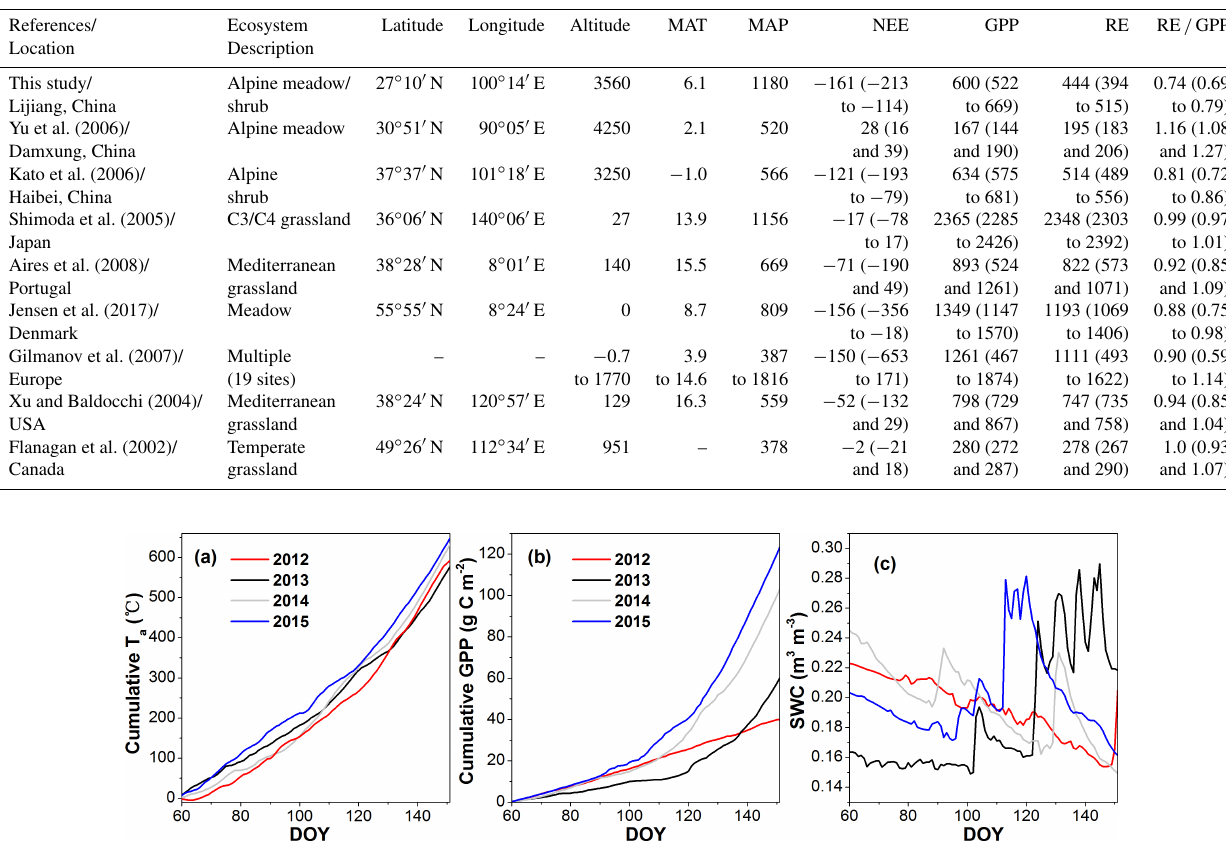
Figure 8. Cumulative (a) T a and (b) GPP and (c) the daily mean SWC from March to May (DOY60 to 151) for 2012, 2013, 2014 and